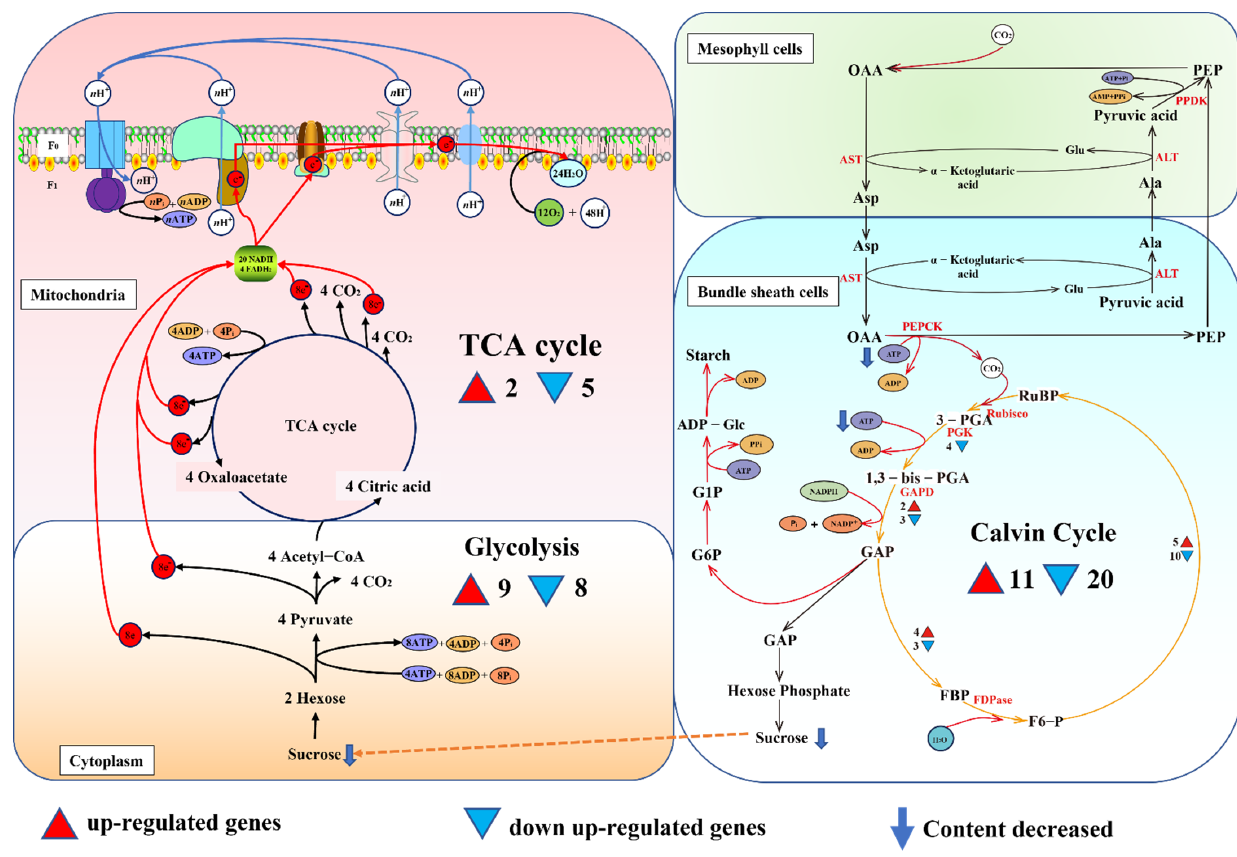
Figure 7. The carbon metabolism in maize seedling leaves under phospholipase C inhibition. (OAA: oxaloacetate; PEP: phosphoenolpyruvic acid; Asp: aspartic acid; Ala: alanine; PPDK: pyruvate phosphate dikinase; ALT: alanine aminotransferase; AST: aspartate aminotransferase; PEPCK: phos- phoenolpyruvate carboxykinase; RuBP: ribulose diphosphate; Rubisco: ribulose diphosphate carboxy- lase; 3-PGA: 3-phosphoglyceric acid; 1,3-bis-PGA: 1,3-diphosphoglyceric acid; PGK: phosphoglycer- ate kinase; GAPD; glyceraldehyde-3-phosphate dehydrogenase; FDPaes: fructose 1,6-diphosphate phosphatase; GAP: glyceraldehyde triphosphate; FBP: fructose 1,6-bisphosphate; F6-P: fructose 6-phosphate; G6P: glucose 6-phosphate; G1P: glucose